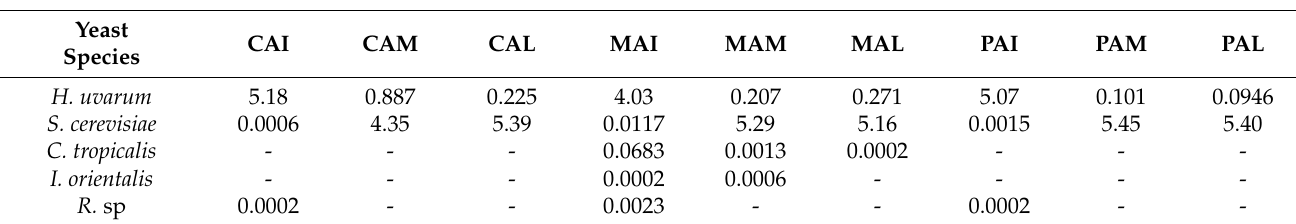
Table 4. Changes in yeast flora during fermentation.